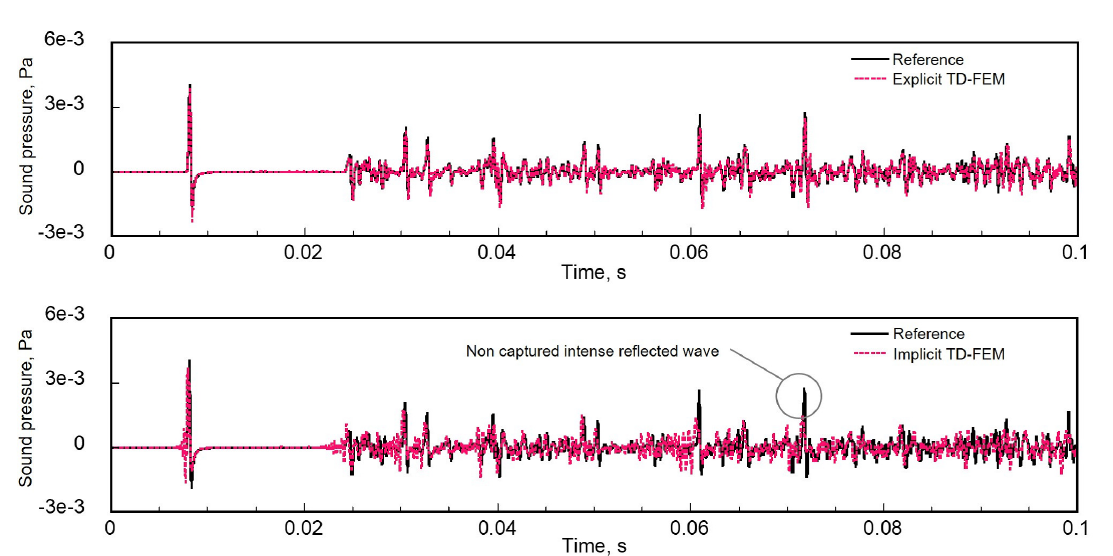
Figure 10. Comparisons of sound pressure waveforms at a receiver ( x , y ) = (5.3, 3.0) among the reference solution, the proposed explicit TD-FEM, and the standard implicit